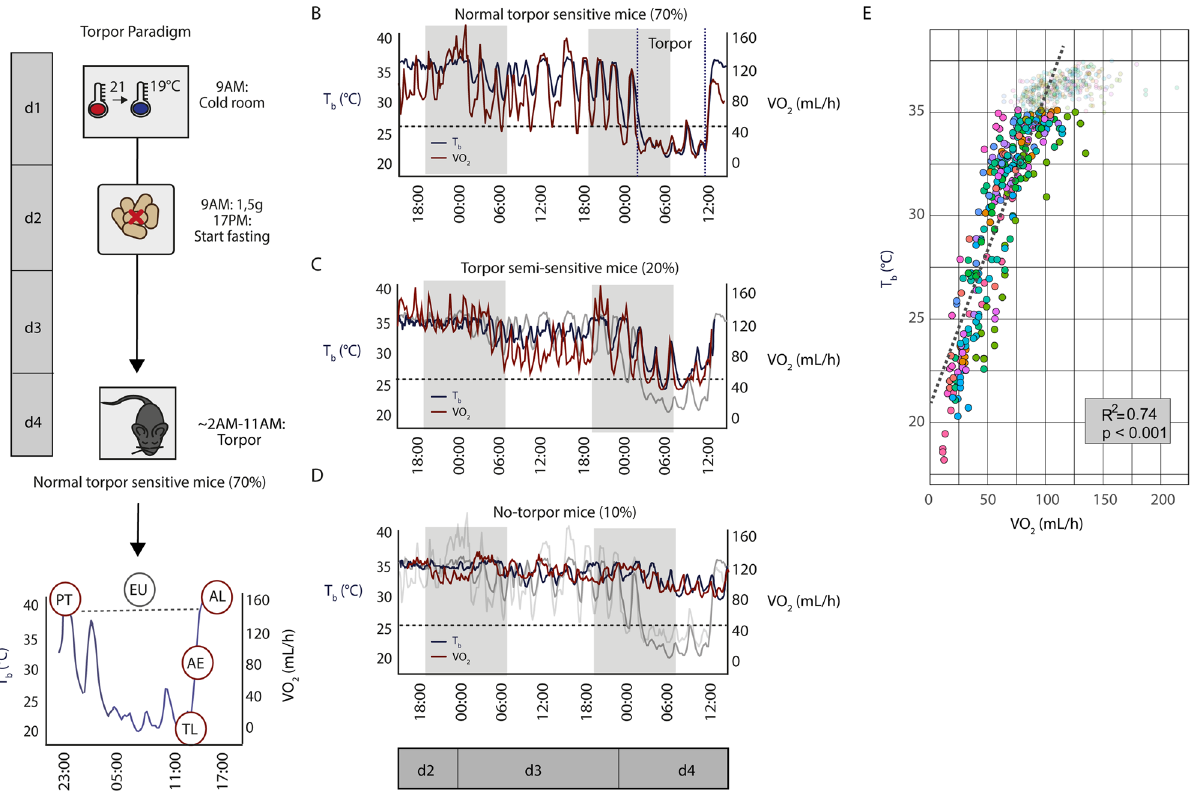
Figure 1. Torpor induction in mice. ( A ) Steady torpor is induced in mice using ambient temperature reduction on day 1 (T a 21 → 19 °C) and food restriction on day 2 (1.5 g from 9:00AM till 17:00PM), followed by a fasting period of maximally 40 h. During the second night of fasting, ~ 70% of the mice enter torpor. Torpor stages were defined as pre-torpor (PT; T b > 36 °C / VO 2 > 120 mL/h); torpor late (TL; T b < 26 °C and/or VO 2 < 40 mL/h for at least 6 h); arousal early (AE; T b of ~ 30 °C and VO 2 of ~ 80 mL/h); arousal late (AL; T b 37 °C and VO 2 > 120 mL/h for 2 h). Euthermic (EU) animals were held at normal housing temperature and fed ad lib. ( B ) Representative core body temperature (T b ) and metabolic rate (VO 2 ) graphs of normal torpor sensitive mice (70%; n = 21/30 mice). An average torpor bout lasted 9 ± 0.65 h ( n = 12) with T b (blue line) dropping to ~ 21 °C and VO 2 (red line) dropping to ~ 20 mL/h VO 2 . ( C ) Torpor semi-sensitive mice (20%; n = 6/30 mice) did not reach stable T b < 26 °C, and ( D ) no-torpor mice (10%; n = 3/30 mice) do not enter torpor after two nights of fasting. Normal torpor graphs are shown in grey for reference. ( E ) T b (°C) and VO 2 (mL/h) were highly correlated ( n = 12 mice; R 2 = 0.74, p <